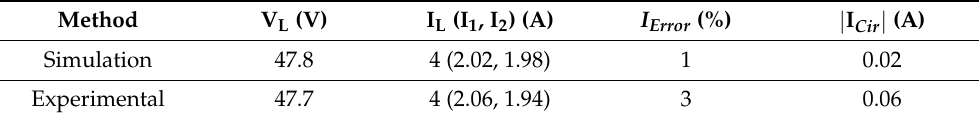
Table 12. Comparison of simulation and experimental results of the proposed adaptive droop control for different cable resistances.